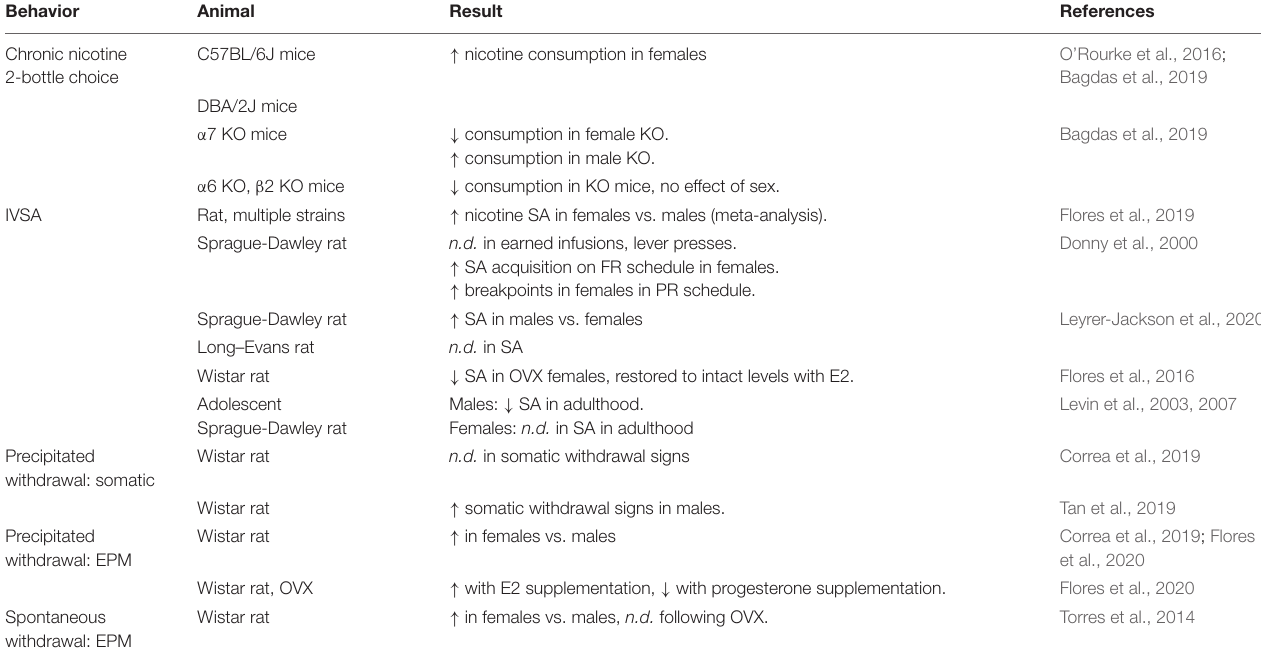
TABLE 3 | Summary of sex differences in highlighted nicotine behavioral